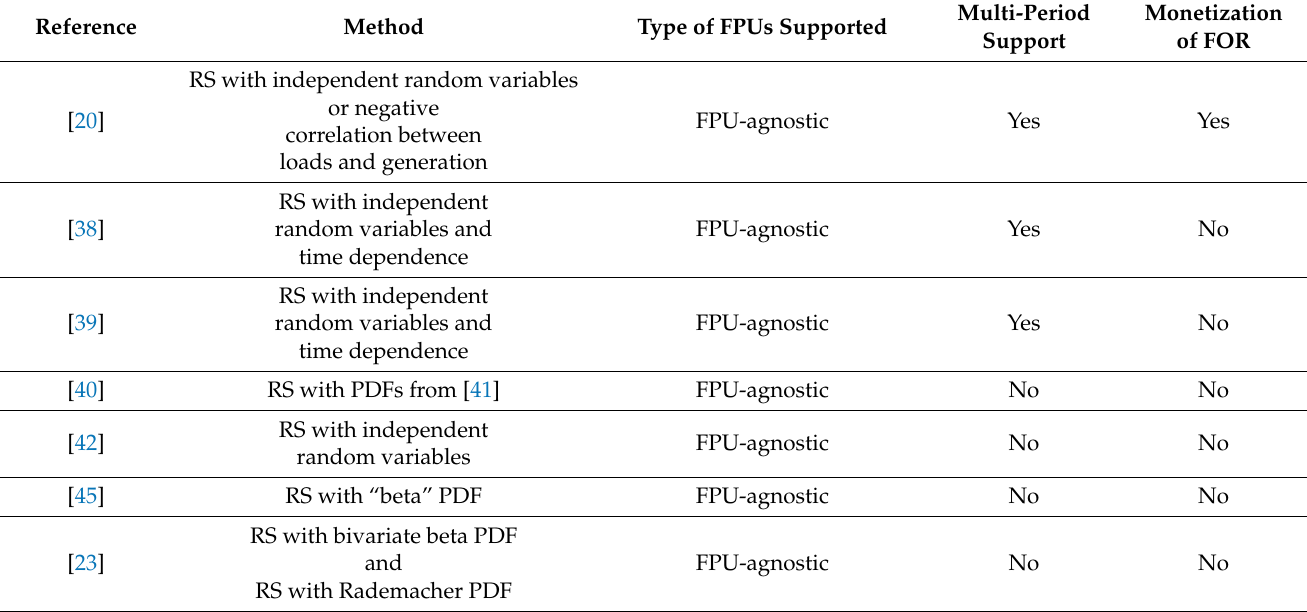
Table 3. A summary of the reviewed RS